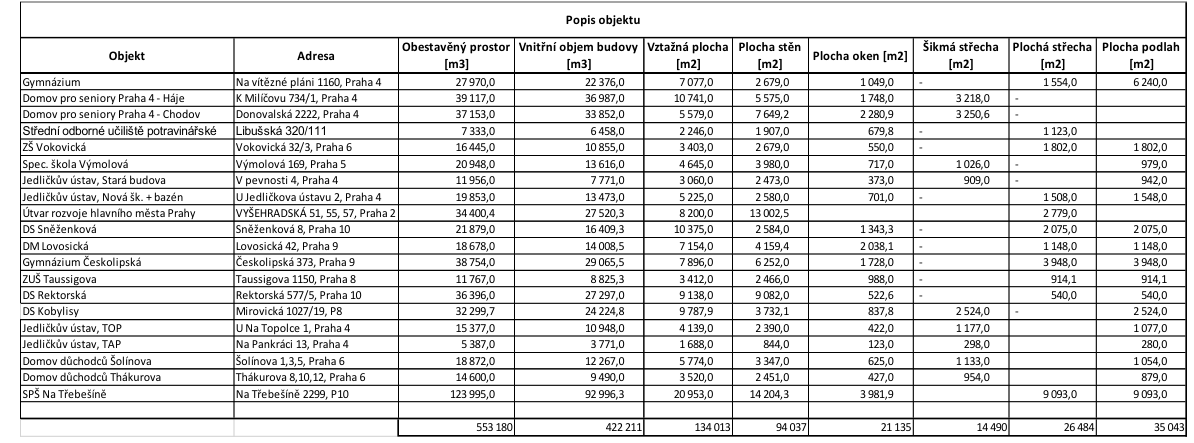
Energeticky vztažná plocha trojnásobně převyšuje požadavek na indikátor OP.